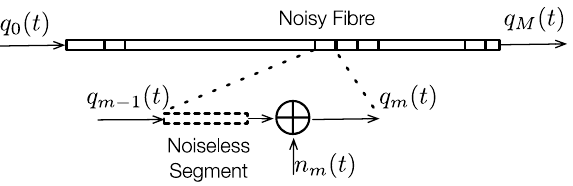
Figure 1. Noise addition model. Fibre is divided into “ M ” segments. In each segment, the noise is modelled by approximating it with a noiseless propagation and point noise added at the end of the propagation. The perturbations of eigenvalues and spectra between segments are assumed to be independent. The total perturbation at the end of the fibre is approximated as a linear addition of the perturbations in each segment plus a compensations of the spectral phase based on the distances from each segment to the end of the